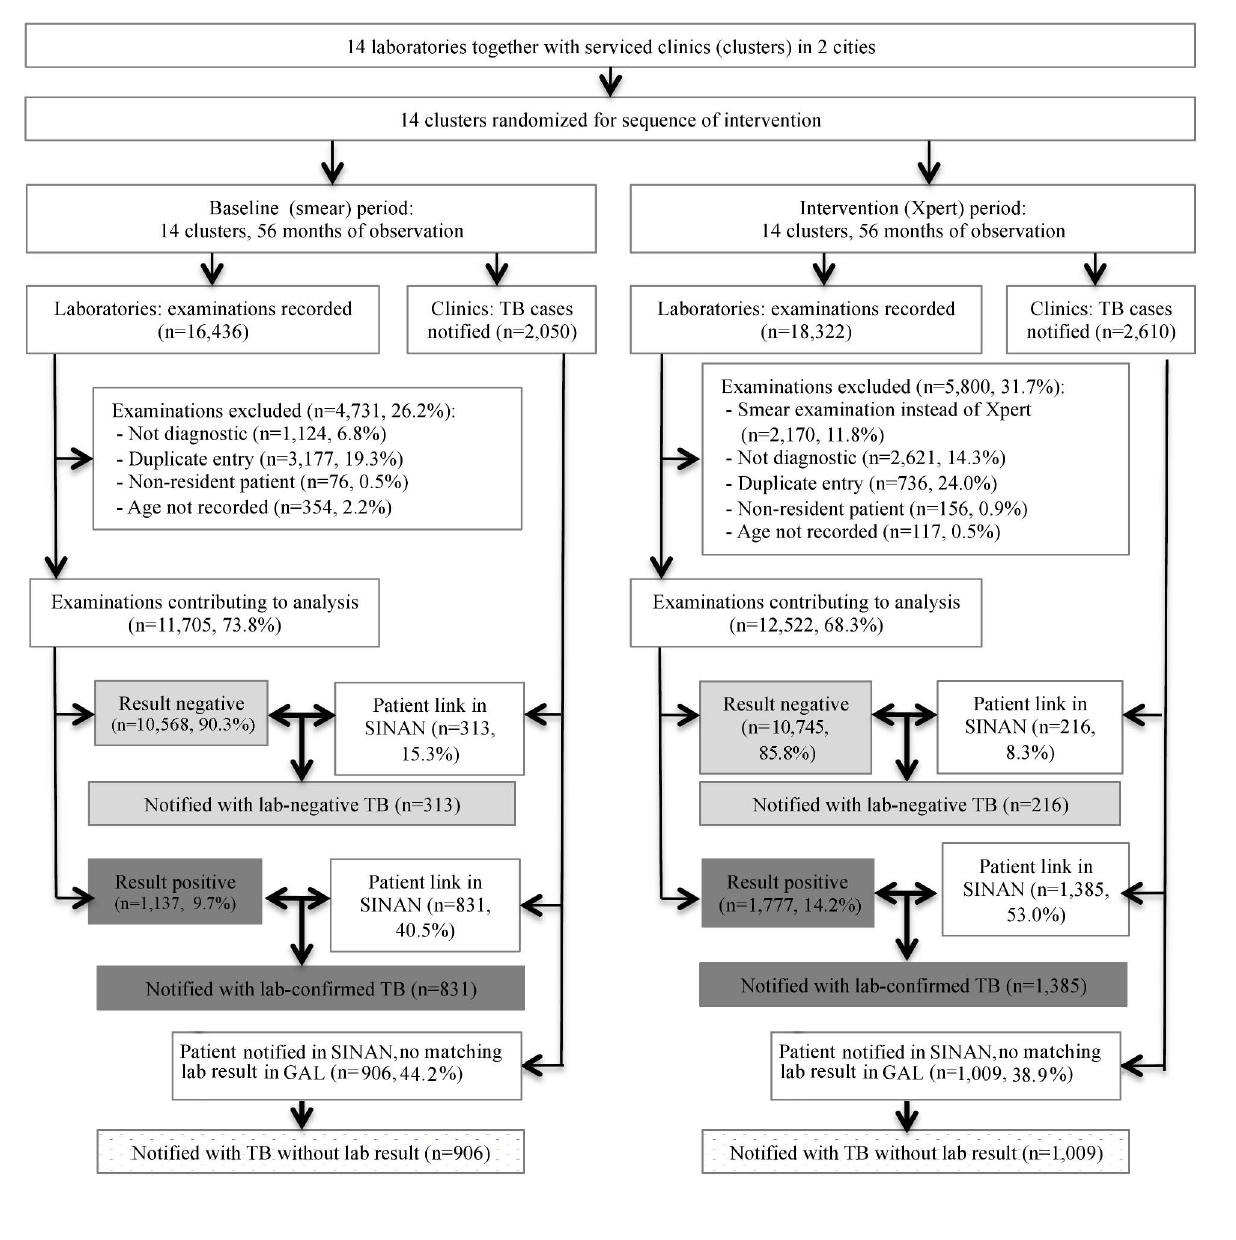
Figure 2. Flowchart showing study inclusion in baseline (smear examination) and intervention (Xpert MTB/RIF) arms. Bold arrows indicate cross-linkage between databases.